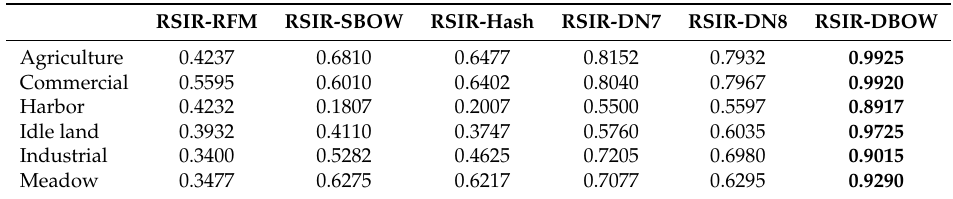
Table 5. Retrieval precision of different RSIR methods across 12 semantic categories in ImgDB3 counted by the top 20